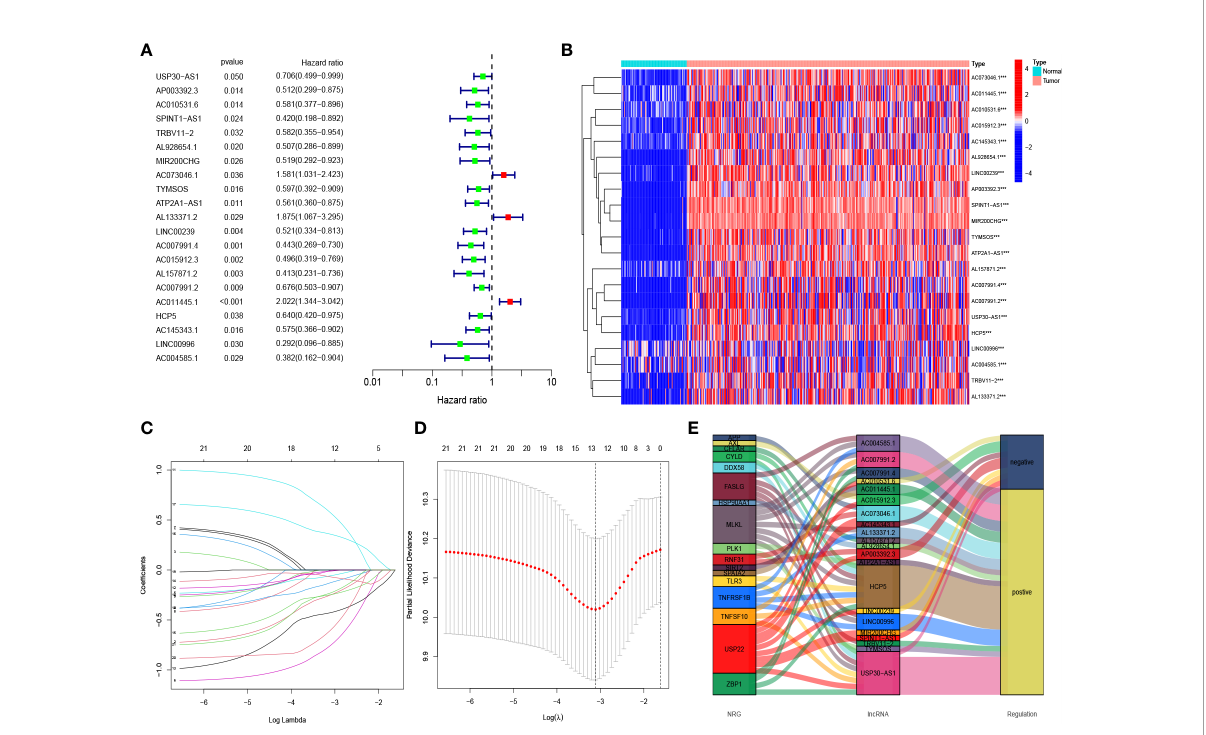
FIGURE 3 Risk prediction signature model in patients with OC (A) The prognostic lncRNAs obtained with uni-Cox regression analysis. (B) The heatmap of differentially expressed lncRNAs. (C) In the LASSO model, the 10-fold cross-validation for variable selection. (D) Cross-validation of error curves is performed with the tuning parameters (log l ) of patients ’ OS-related lncRNAs. The imaginary perpendicular line is also dragged to the excellent value. (E) Necroptosis genes and lncRNAs are shown in the Sankey